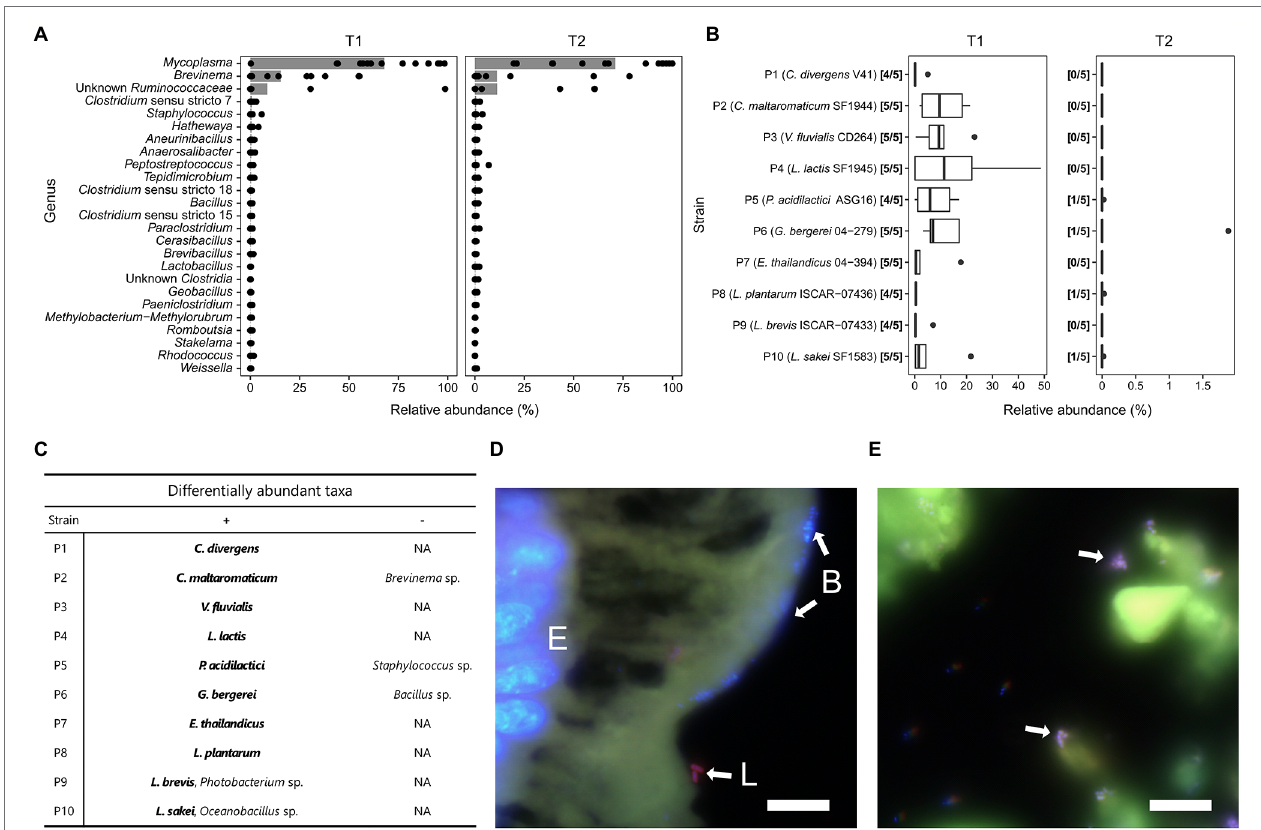
FIGURE 3 | Description of Arctic char gut microbiota. (A) Relative abundance of genera (or higher taxon if genus is unknown) in fish guts of the control group ( n = 15) at time T1 and T2. Gray bars indicate average relative abundance; (B) Relative abundance of probiotic strains detected in fish guts of the treatment groups ( n = 5) at time T1 and T2. Positive detection was assumed if the 16S rRNA gene sequence matched the reference 16S rRNA gene of the respective probiotic strains with 100% sequence similarity; (C) Differentially abundant taxa for each treatment group with significantly higher (+) or lower ( − ) relative abundance compared to the control group. Probiotic strains are marked in bold. (D) FISH image of gut epithelium of treatment group P8 with nuclei of enterocytes (E) and other bacteria (B) stained blue (DAPI), and L. plantarum cells (L.) stained purple (DAPI + Cy3 + Alexa488). Bar: 10 μ m; (E) FISH image of intestinal lumen of treatment group P1 with C. divergens cells marked purple (DAPI + Cy3 + Alexa488). Bar: 10 μ